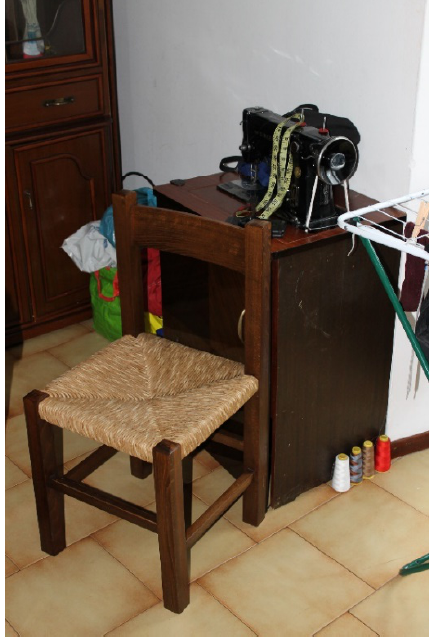
Figure 4: Moussa’s sewing